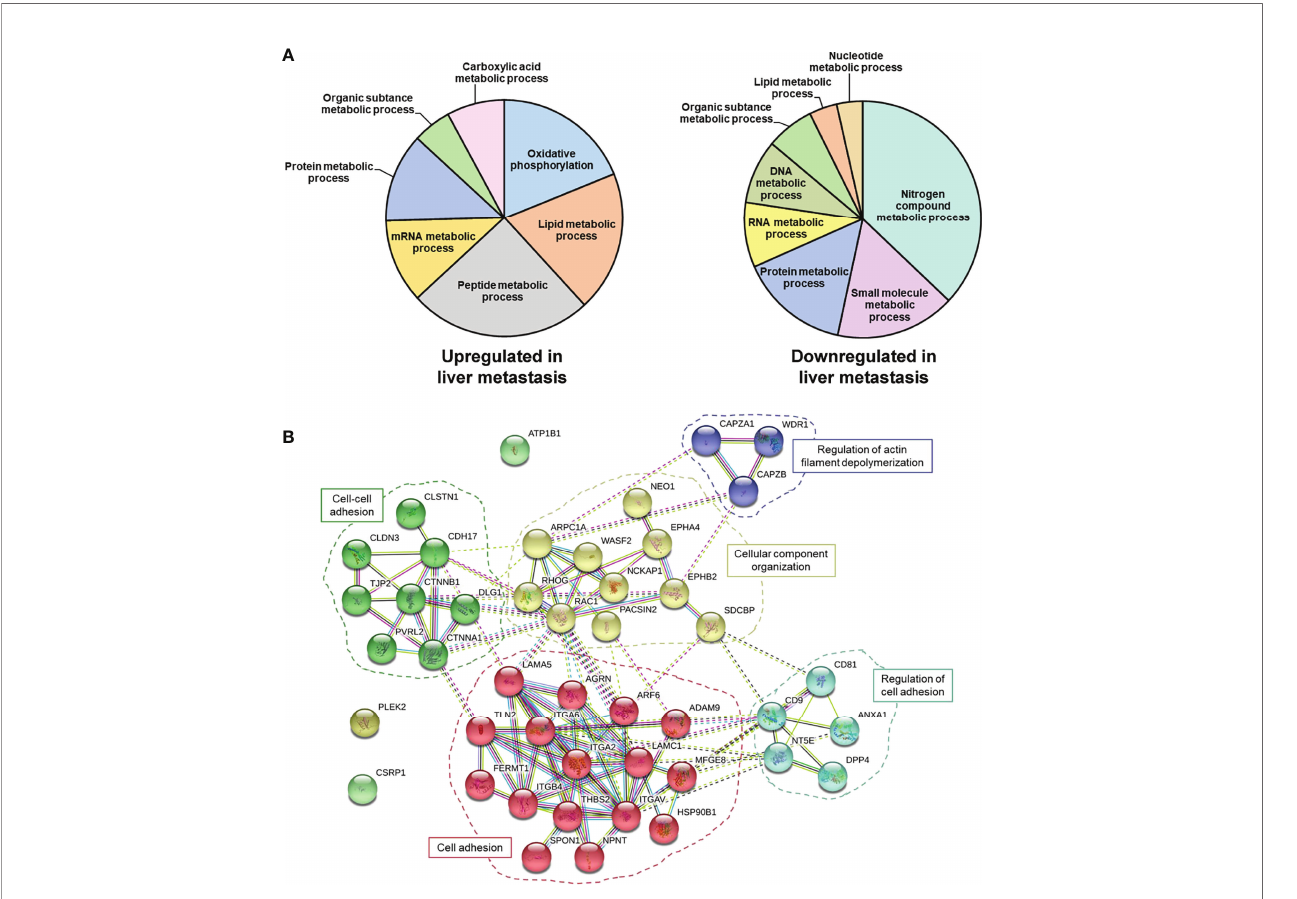
FIGURE 1 | Meta-analysis of proteomics data of liver metastatic KM12SM in comparison to parental non-metastatic KM12C CRC cells. (A) Metabolic processes altered in liver metastasis of CRC cells. A total of 868 dysregulated proteins 334 upregulated and 534 downregulated — in KM12SM cells in comparison to KM12C CRC cells were associated with metabolism. (B) Forty- fi ve dysregulated proteins related to EMT and stemness in CRC liver metastasis were also involved in processes related to cell-cell